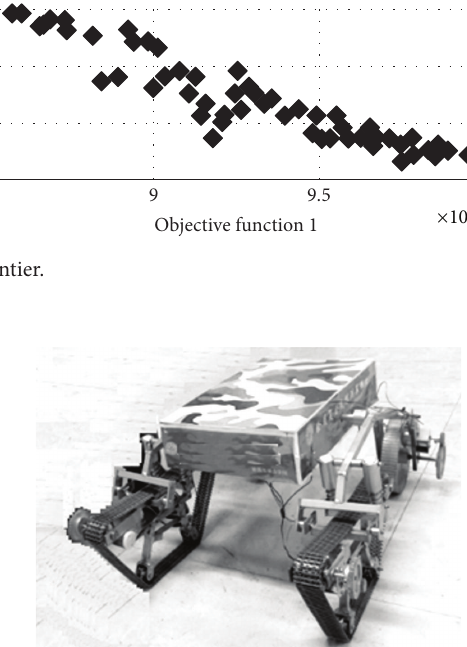
Figure 18: Physical prototype for wheel-tracked exploration